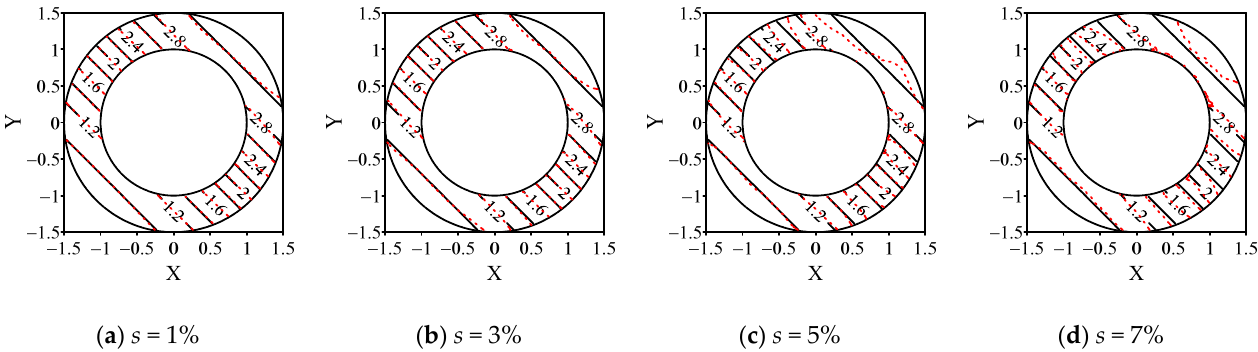
Figure 7. The comparison of numerical (dashed curves) and analytical solutions (solid curves).